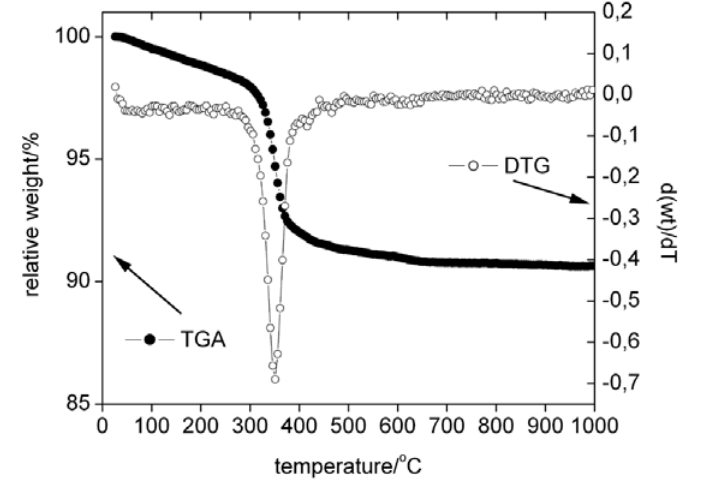
Figure 7 . TGA and DTG curves of the as-prepared sample in air. Note that the relative weight scale (TGA) is only from 85 to 101